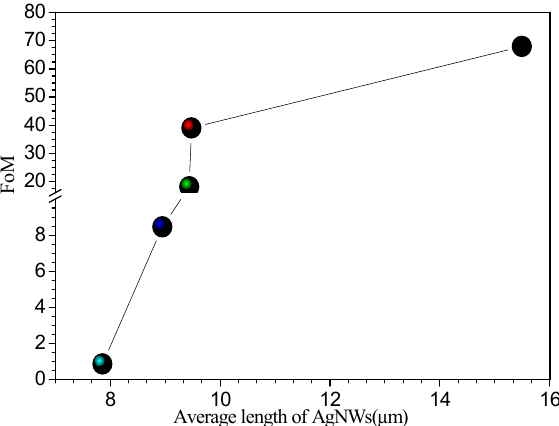
Figure 9. Relationship between figure of merit (FoM) of AgNW-FTCFs and the average AgNW length.